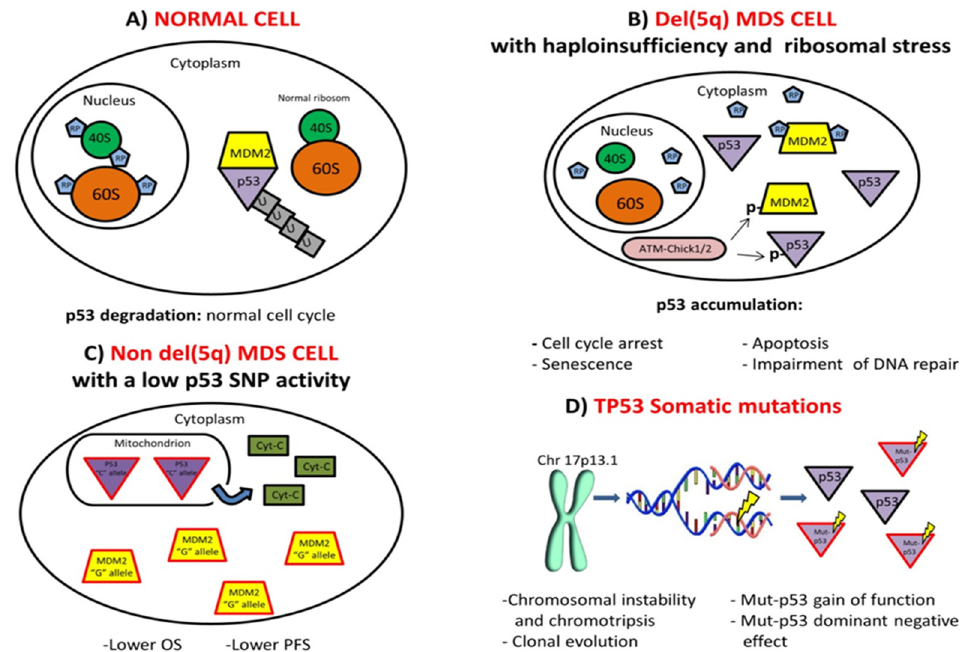
Figure 1. Overview of the molecular pathways activation. ( A ) A normal cell in which MDM2 is free to bind p53. MDM2-p53 binding determines the p53 ubiquitination and consequent p53 degradation, allowing a normal cell cycle. ( B ) A del(5q) myelodysplastic syndromes (MDS) cell with RPS14 haploinsufficiency and nucleolar stress, in which ribosome assembly is impeded and small ribosomal proteins (RP) do not bind 40S and 60S ribosomal subunits but they are free in cytoplasm and bind MDM2. MDM2-RP binding avoids MDM2-p53 interaction resulting in a p53 stabilization, reinforced also from the phosphorylation of both MDM2 and p53 by ATM-Chk1 or ATM-Chk2. The accumulation of p53 leads to cell cycle arrest, impairment of DNA repair, senescence, and apoptosis. ( C ) A non del(5q) MDS cell with a low p53 SNP activity in which the MDM2 SNP309 “G” allele enhances MDM2 expression and p53 “C” allele has an improved apoptosis-promoting potential, in part for its major mitochondrial positioning, activating cytosolic liberation of cytochrome C. This condition determines in patients a significantly lower overall survival (OS) and progression-free survival (PFS). ( D ) Somatic TP53 mutations are related, in MDS patients, with p53 gain of function and dominant negative effect, chromosomal instability, chromotripsis, and clonal evolution.